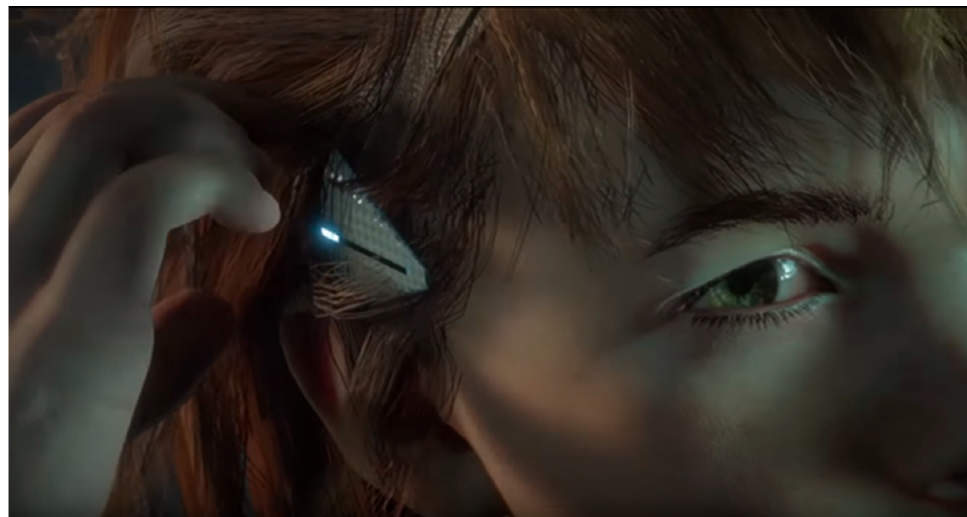
Figure 13. Aloy as a child with her “Focus” (the little triangular device above her ear).